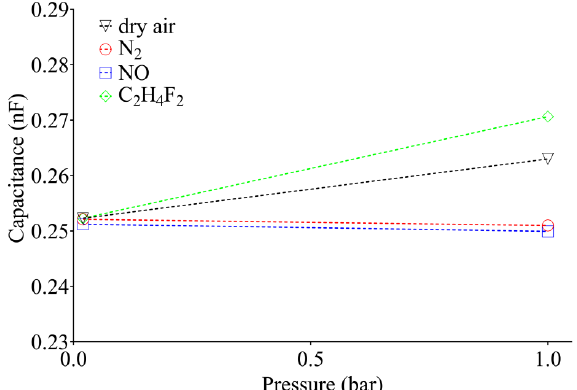
Figure 9. Relation between capacitance of the sample maintained at 20 mbar for 1 h and the latter after injection of gas at 1 bar for 40 min.